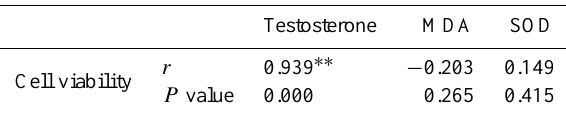
Table 2. Correlations between cell viability, on the one hand, and testosterone production, MDA, and SOD level on the